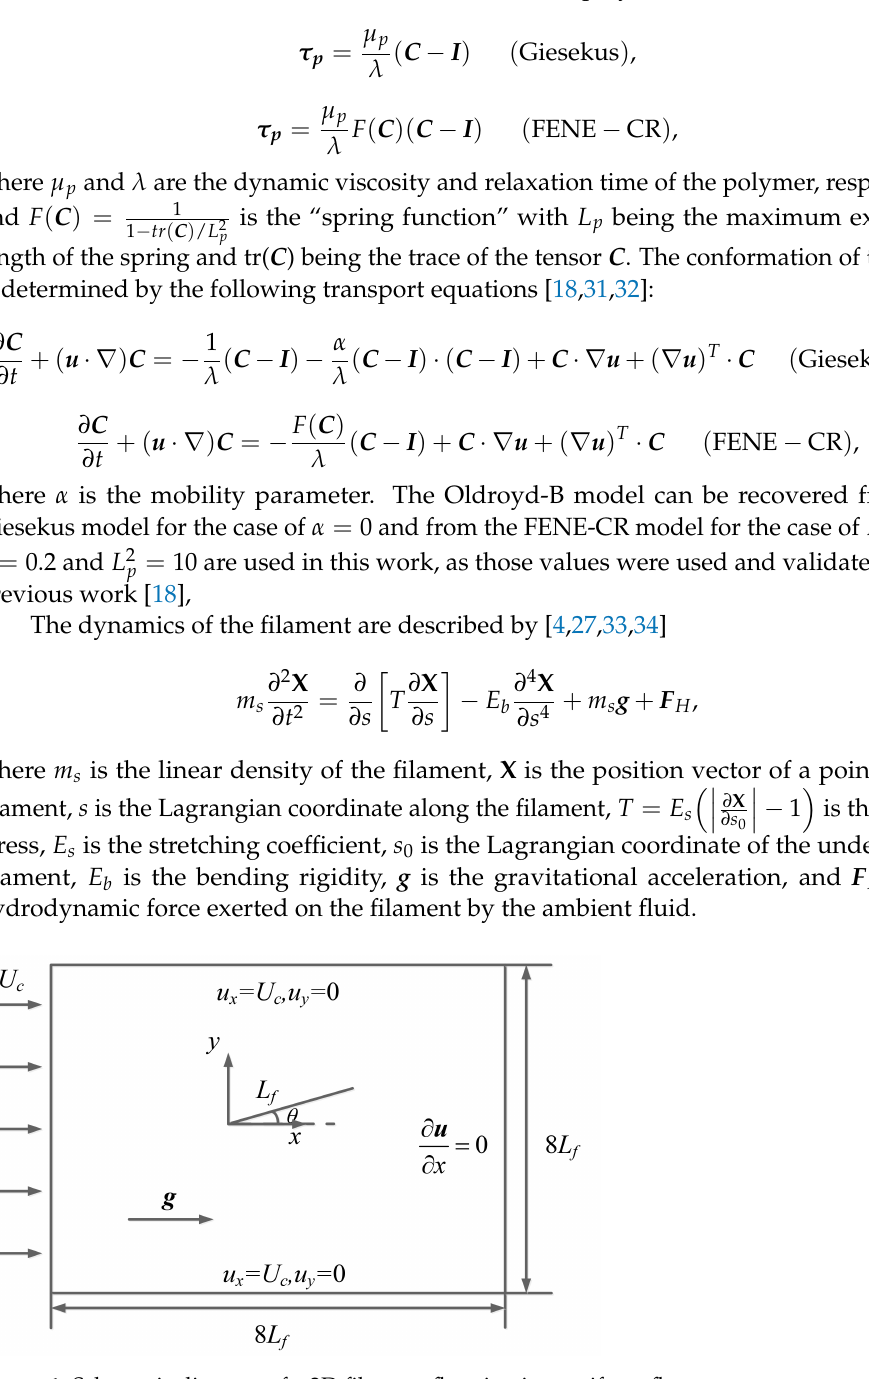
Figure 1. Schematic diagram of a 2D filament flapping in a uniform